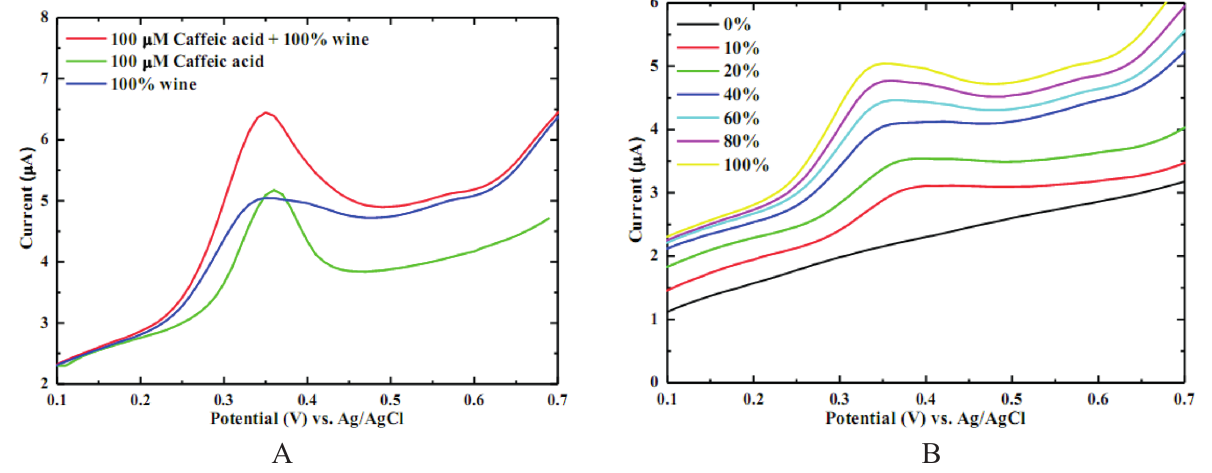
Figure 1: Cyclic voltammograms obtained at caffeic acid and white wine analysis; caffeic acid generated the most pronounced peak when added to the wine sample (A) and the analytical signal for the wine sample was recorded at different dilutions